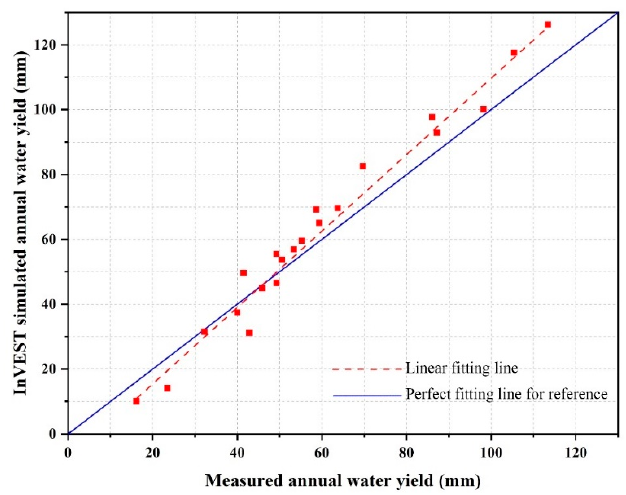
Figure 11. InVEST simulated annual water yield against measured annual water yield.